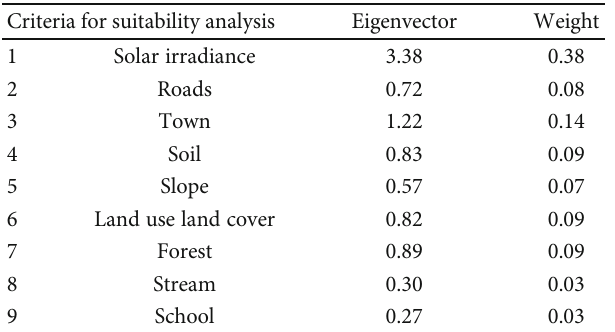
Table 7: Solar irradiance reclassi fi